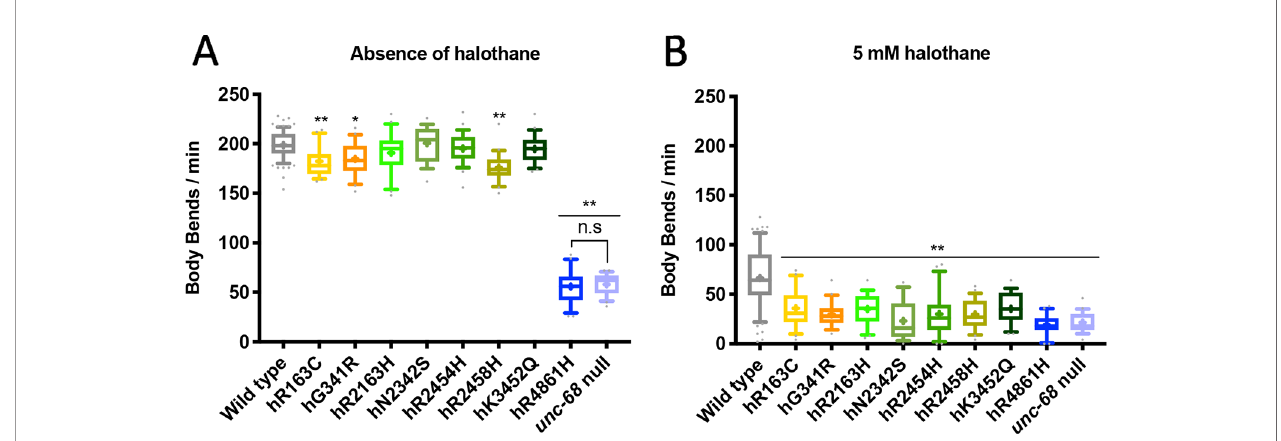
FIGURE 1 | Ryanodine receptor (RyR) variants confer a malignant hyperthermia (MH)-related phenotype of hypersensitivity to halothane. Thrashing rate in S medium, in body bends per minute, for RyR variant strains, labelled by the human variant they correspond to, in the absence of (A) and presence of (B) 5 mM halothane / 4% DMSO. 25 individual young adults were examined per strain. Boxes indicate the median and interquartile range, with whiskers to the 10 – 90 percentile, outliers as dots, and + to indicate the mean. Signi fi cance is between variant strains and the N2 wild type, apart from where indicated to the CB540 unc- 68(e540 ) null mutant. * P < 0.05, ** P < 0.005, n.s, not signi fi cant (one-way ANOVA, with Tukey ’ s multiple comparison test). Colouring corresponds to variant location in the protein. Yellow/orange variants are located within the N-terminal domain (NTD), green in the helical domain (HD), and blue in the transmembrane domain (TMD). Gray represents wild type and lilac the null mutant.